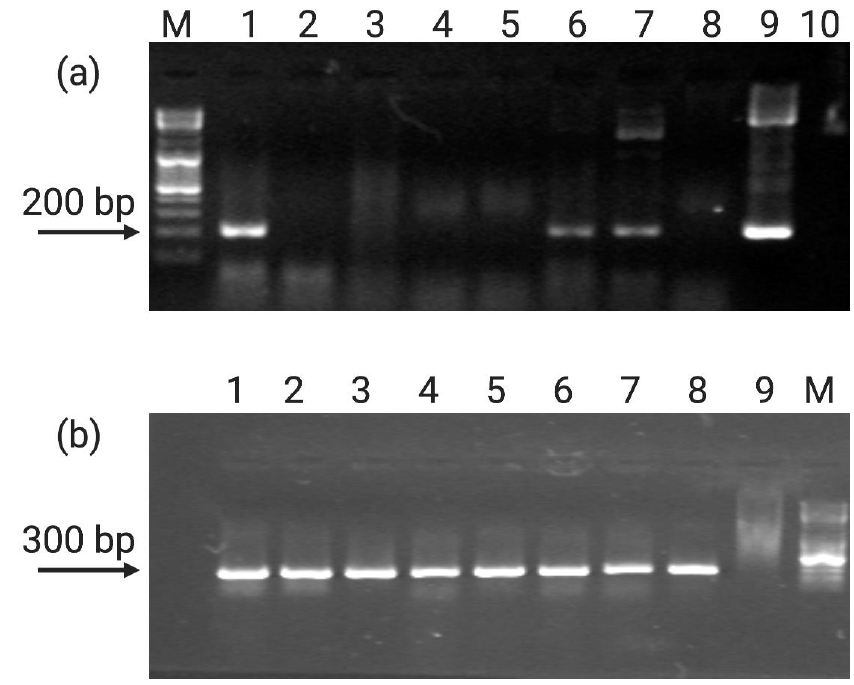
Figure 4. Electrophoretic profile showing the presence of GUS amplified fragment (215 bp) ( a ) and the housekeeping chloroplastic gene ( b ) in transformed A. oleracea shoots. (a)M: Gene Ruler